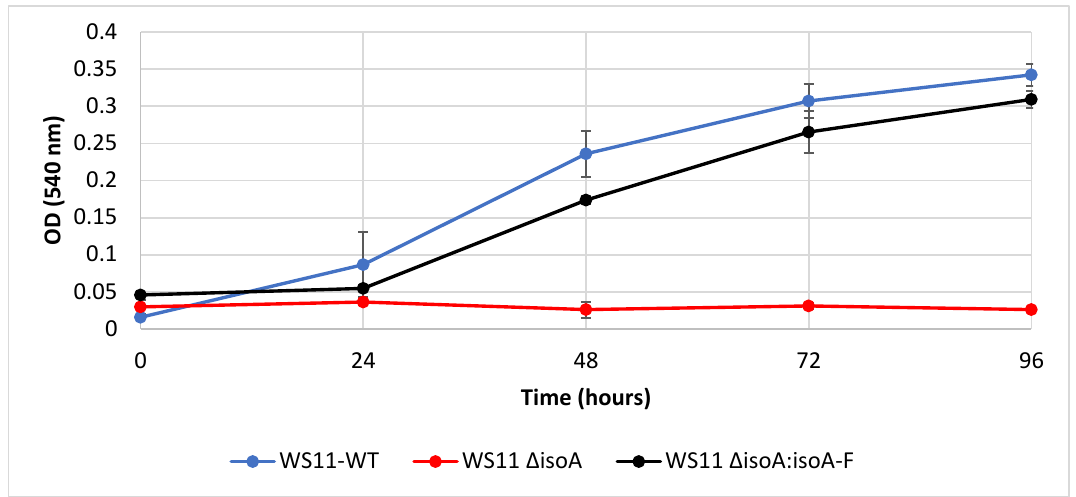
Figure 3. Wild-type Variovorax sp . WS11 (WS11-WT) and complemented isoA mutant (WS11 ∆ isoA : isoA-F ) grow to a similar culture density when provided with 1% v / v isoprene, but isoA deletion strain (WS11 ∆ isoA ) cannot grow on isoprene. Time points are the mean of three biological replicates and the error bars represent the standard deviation.